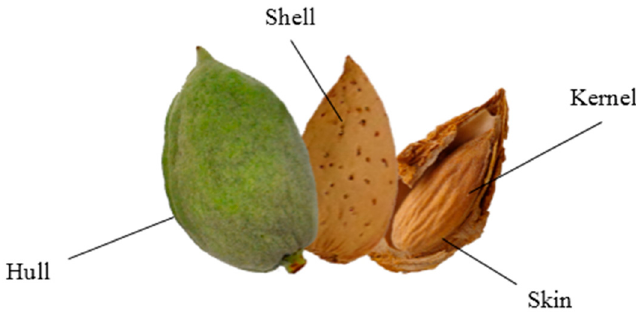
Figure 1. Parts of almond fruit.